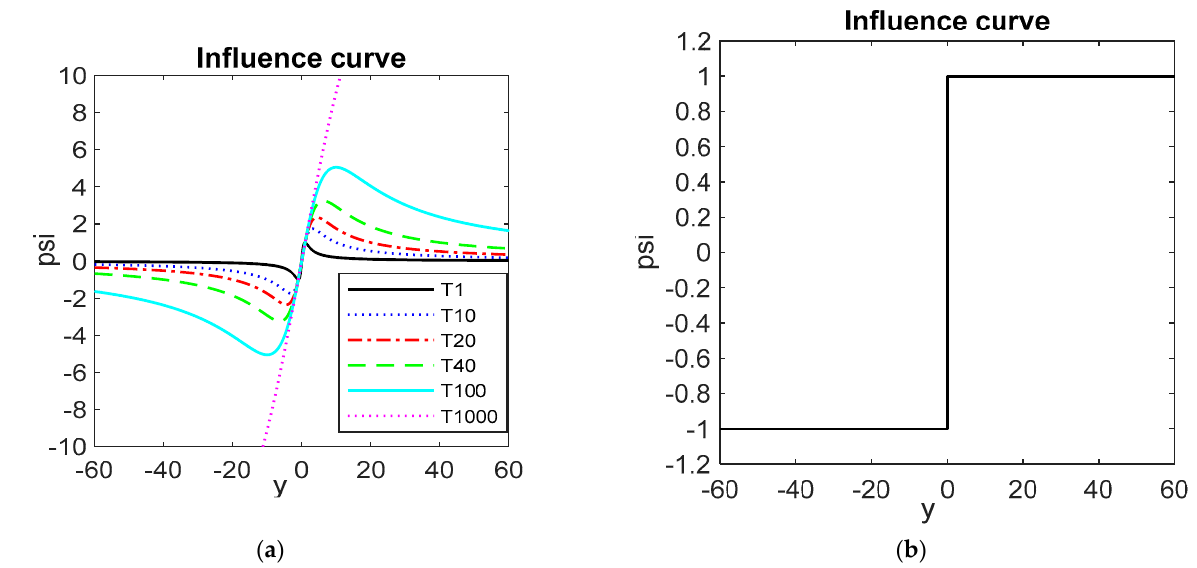
Figure 2. ( a ) ϕ function of EMTr and ( b ) ϕ function of the